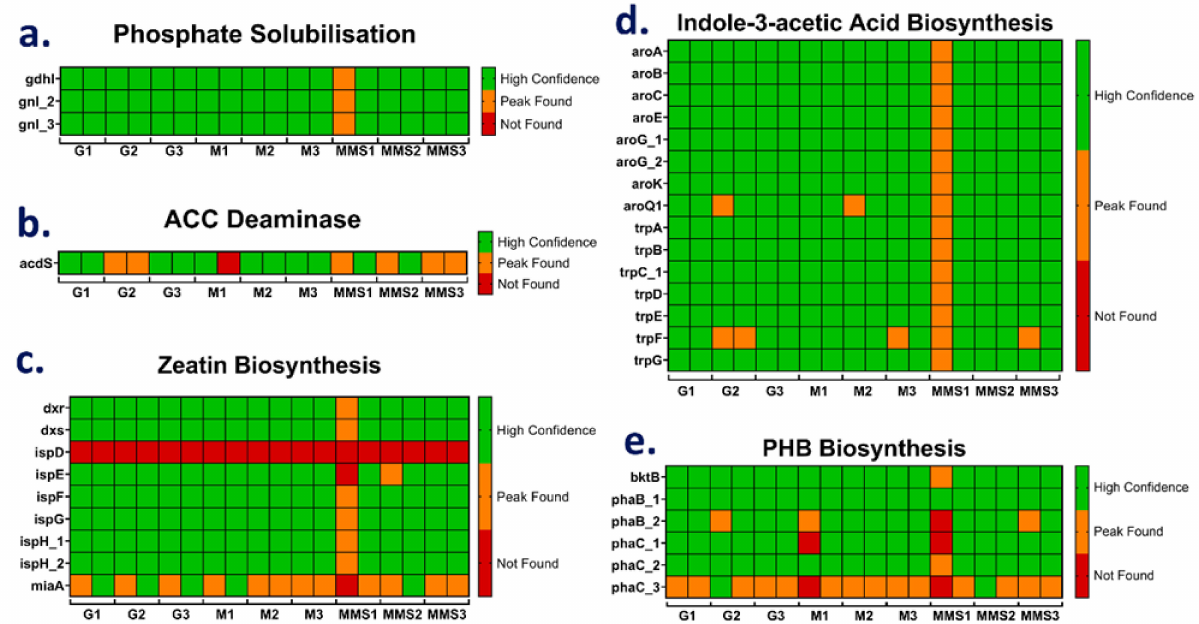
Figure 8. Proteomics identification data of SOS3 cultures grown in various media and at different time-points. ( a ) Key phosphate solubilisation proteins; ( b ) ACC deaminase; ( c ) key zeatin biosynthesis proteins; ( d ) key IAA biosynthesis proteins; ( e ) key PHB biosynthesis proteins. Each medium–time combination (e.g., G2 meaning G-MMS at time 2) was sampled in duplicate from separate